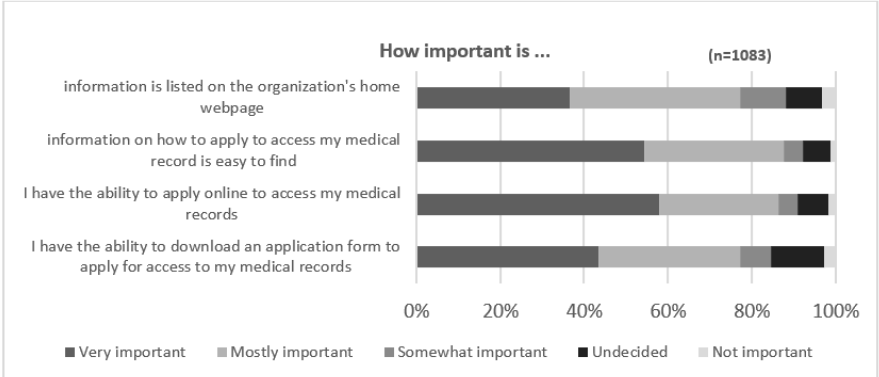
Figure 2. Importance of information on health care websites.